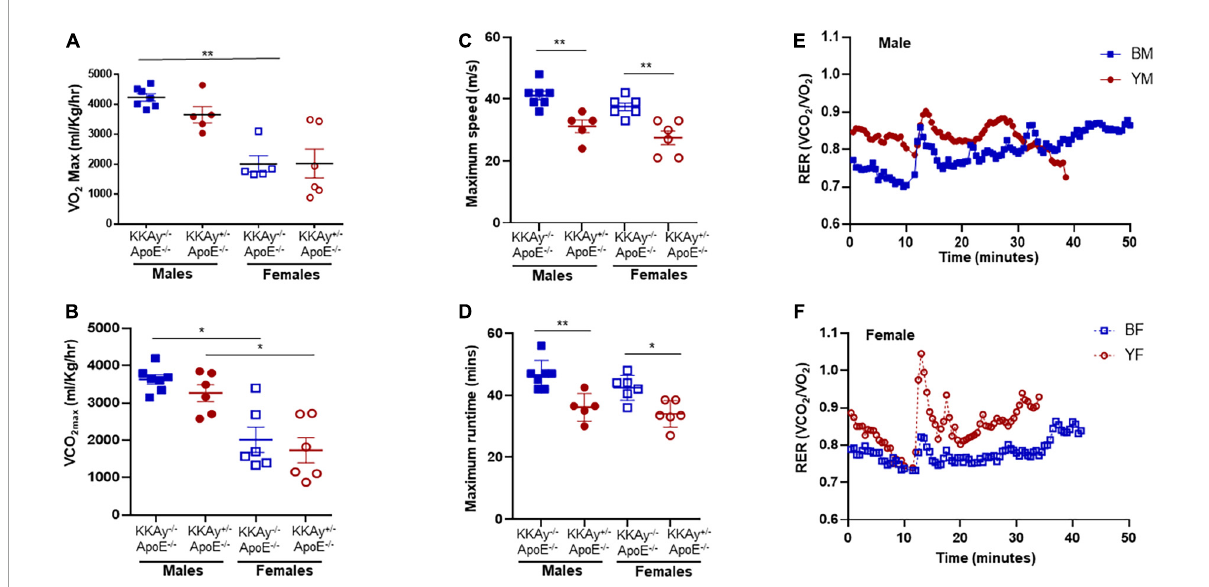
FIGURE2 Sex-specific differences in cardiometabolic fitness of MetS KKAy + / − ApoE − / − and non-MetS KKAy − / − ApoE − / − mice using Treadmill Exercise Test. Mice were trained on the treadmill on day 1 and tested using a treadmill exercise test on day 2 with gradial increase in speed at constant incline. Shown are (A) maximum oxygen consumption (VO 2max ), (B) carbon dioxide produced relevant to maximal oxygen uptake (VCO 2max ), (C) maximum running speed, (D) maximum runtime until exhaustion. Line graphs depicting average RER for (E) representative male MetS KKAy + / − ApoE − / − (YM) and non-MetS KKAy − / − ApoE − / − (BM) mice and (F) representative female MetS KKAy + / − ApoE − / − (YF) and non-MetS KKAy − / − ApoE − / − (BF) mice. For panels (A–D) , data are mean ± SEM. For all the panels n = 5–7 mice per genotype. * p < 0.05, ** p < 0.005.